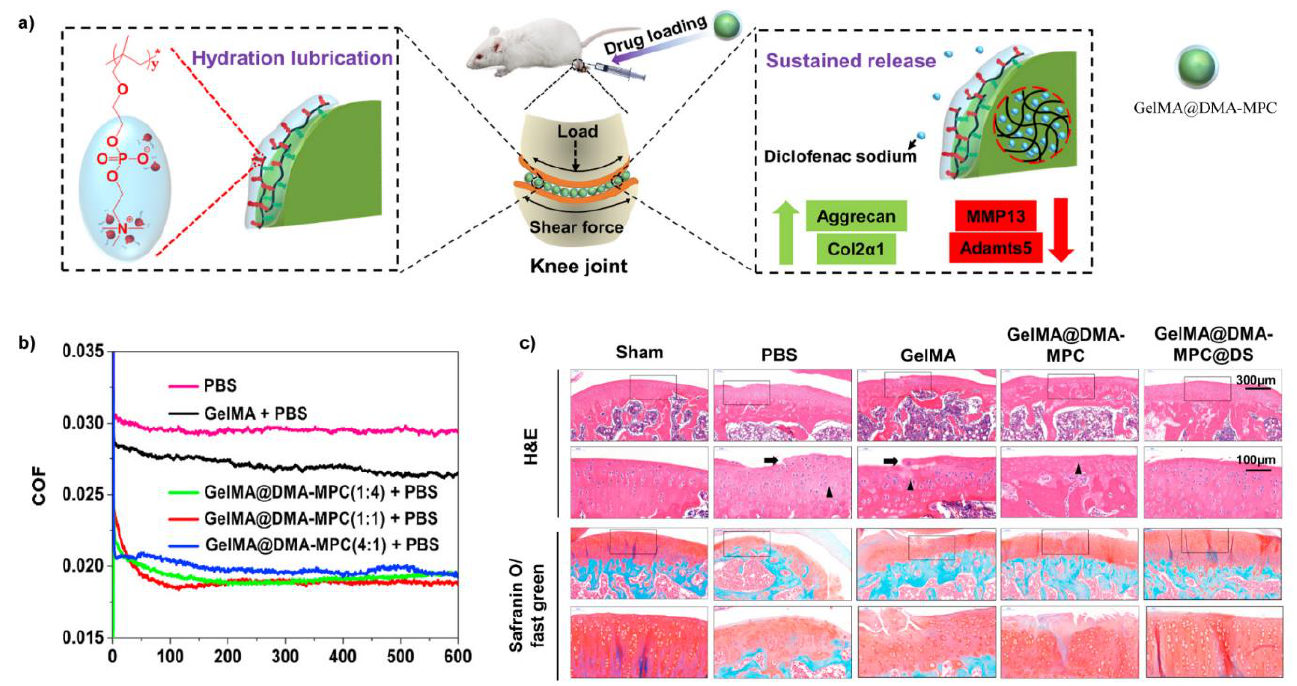
Figure 8. ( a ) Schematic of OA treatment by articular-injecting of dual-functional GelMA@DMA-MPC@DS with enhanced lubrication and sustained release of the drug; ( b ) The plots of friction coefficients versus time using PTFE pin and a silicon wafer as friction pairs; ( c ) Representative images of histological staining assay showed the disruption of cartilage with different treatments. The black arrow shows the fissures within cartilage, the black triangle indicates tissue cellularity with cloning. Reprinted with permission from ref. [111]. Copyright 2021 KeAi publishing.